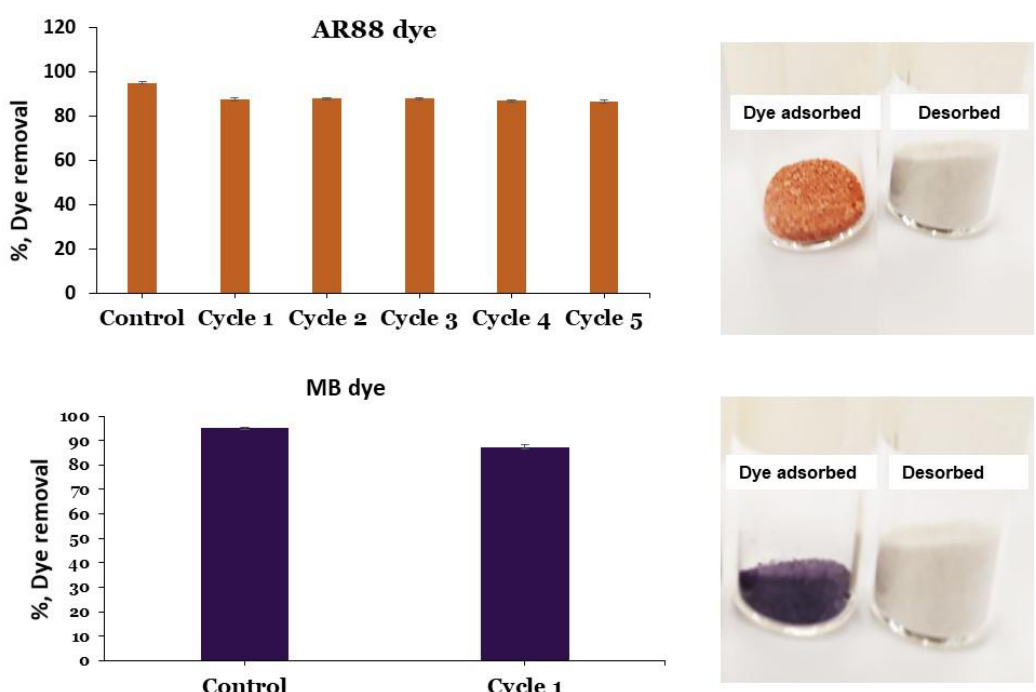
Figure 9. Recycling of the PRGMs for the removal of AR88 and MB (For AR88 C 0 = 180 mg/L, Adsorbent dose = 5 g/L and pH = 2.5; MB, C 0 = 25 mg/L, Adsorbent dose = 5g/L and pH = 7).